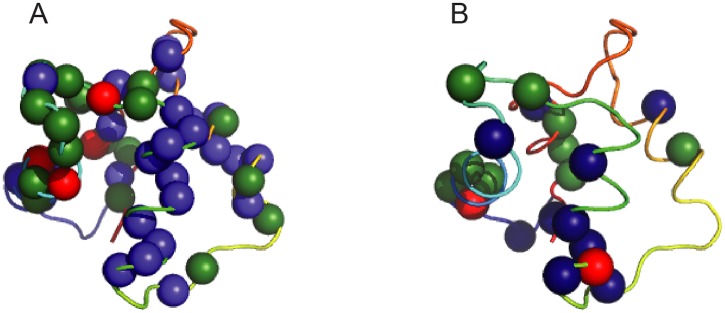
Spatial distribution of exchanging backbone 15N and 13CO nuclei of CLD N-lobeCa.Exchanging nuclei are shown as spheres on the structure of CLD N-lobeCa colored as in Fig 3. (A) Exchanging backbone 15N nuclei. The color coding is |ΔϖCPMG| <2 ppm (indigo), 2 < |ΔϖCPMG| < 3 ppm (green) and |ΔϖCPMG| > 3 ppm (red). (B) Exchanging backbone 13CO nuclei. The color coding is |ΔϖCPMG| <0.75 ppm (indigo), 0.75 < |ΔϖCPMG| < 1.0 ppm (green) and |ΔϖCPMG| > 1.0 ppm (red).